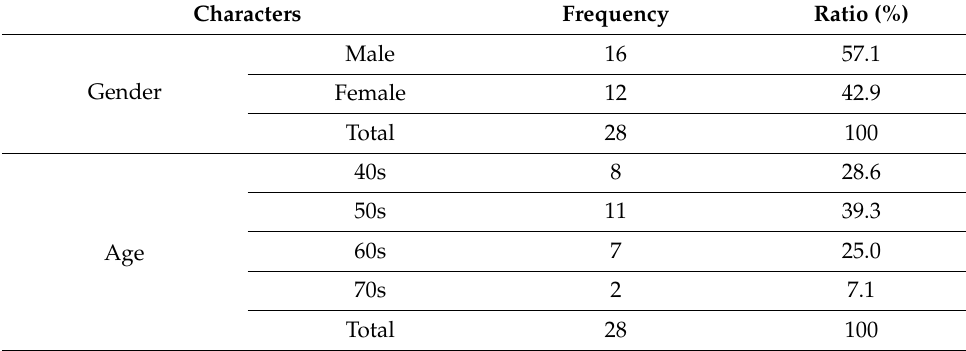
Table 5. Demographic